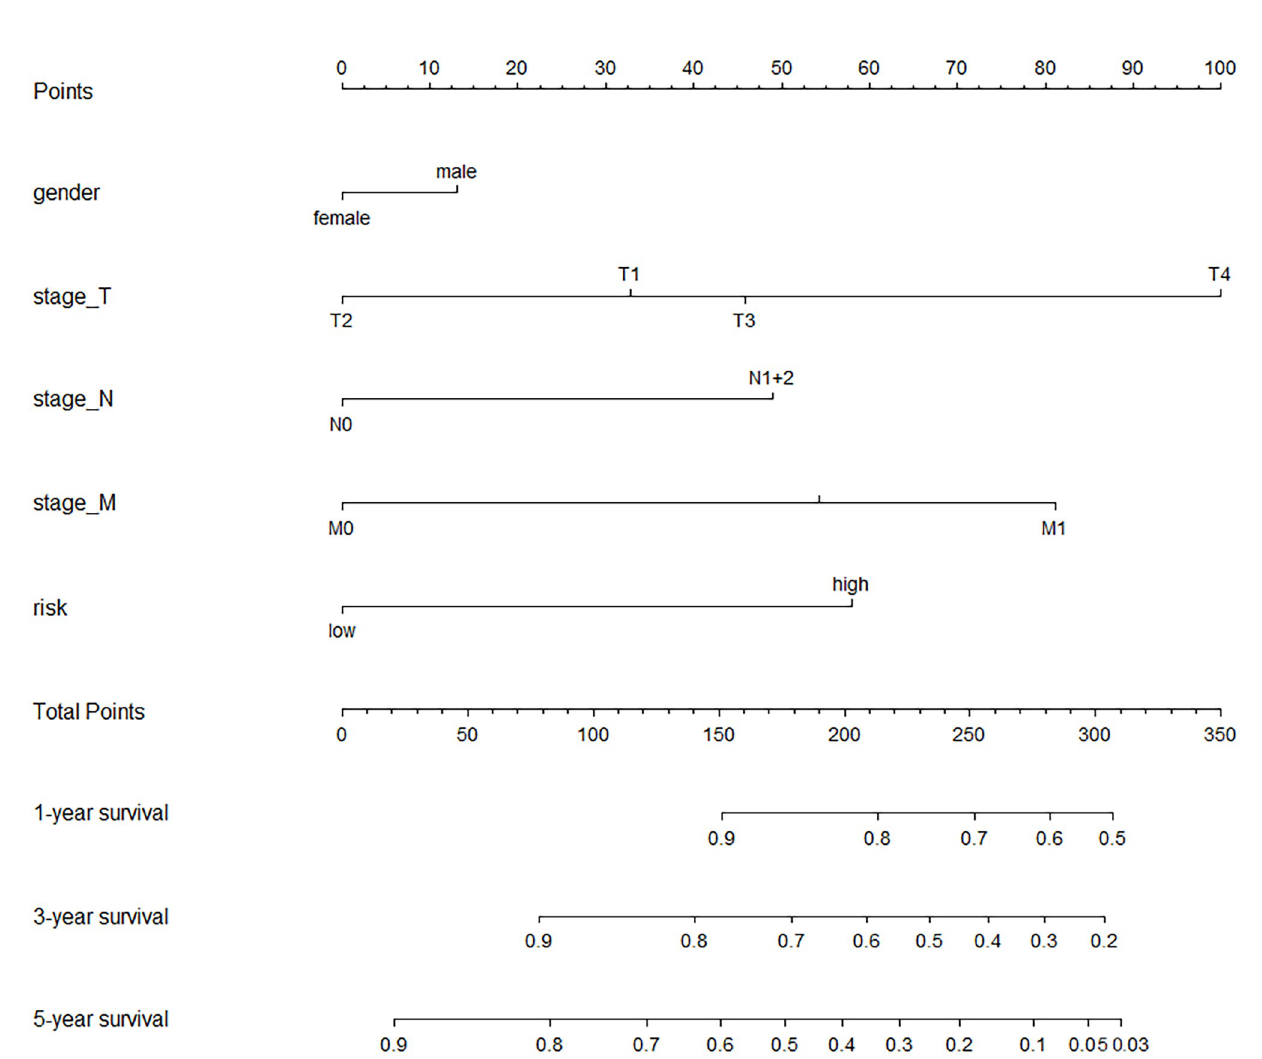
Fig 5. The nomogram. A nomogram for predicting the survival probability of CC patients with 1-, 3- and 5-year OS. CC, colon cancer; OS, overall survival.